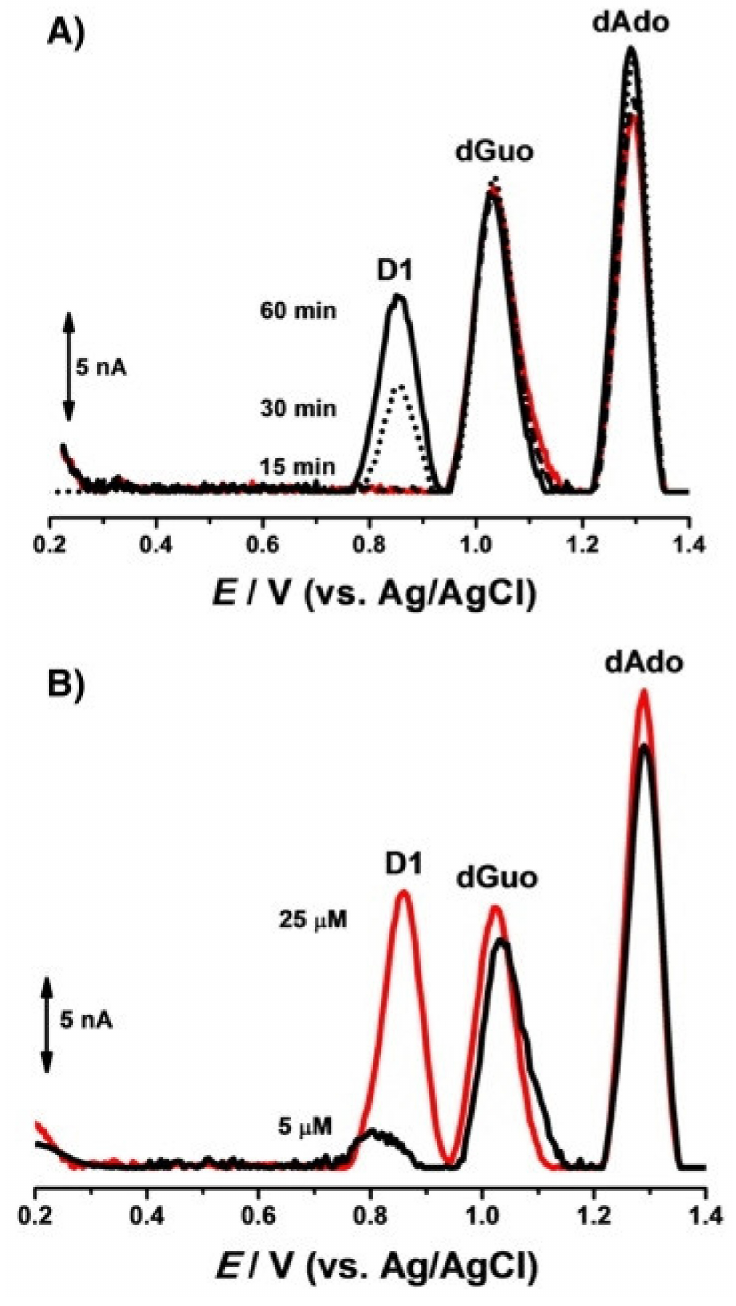
Figure 4. DP voltammograms, with no conditioning potential, in a 0.1 M acetate buffer with a pH of 4.5, with the dsDNA-electrochemical biosensor after: ( A ) ( ▬ ) 30 min in the buffer control experi- ment, and incubation in: 10 μ M of danusertib during (•••) 15, ( ⁃⁃⁃ ) 30 and ( ▬ ) 60 min, and ( B ) incubation in ( ▬ ) 5 μ M and ( ▬ ) 25 μ M of danusertib during 30 min. Figure adapted from the refer- ence [45] with permission from Elsevier.